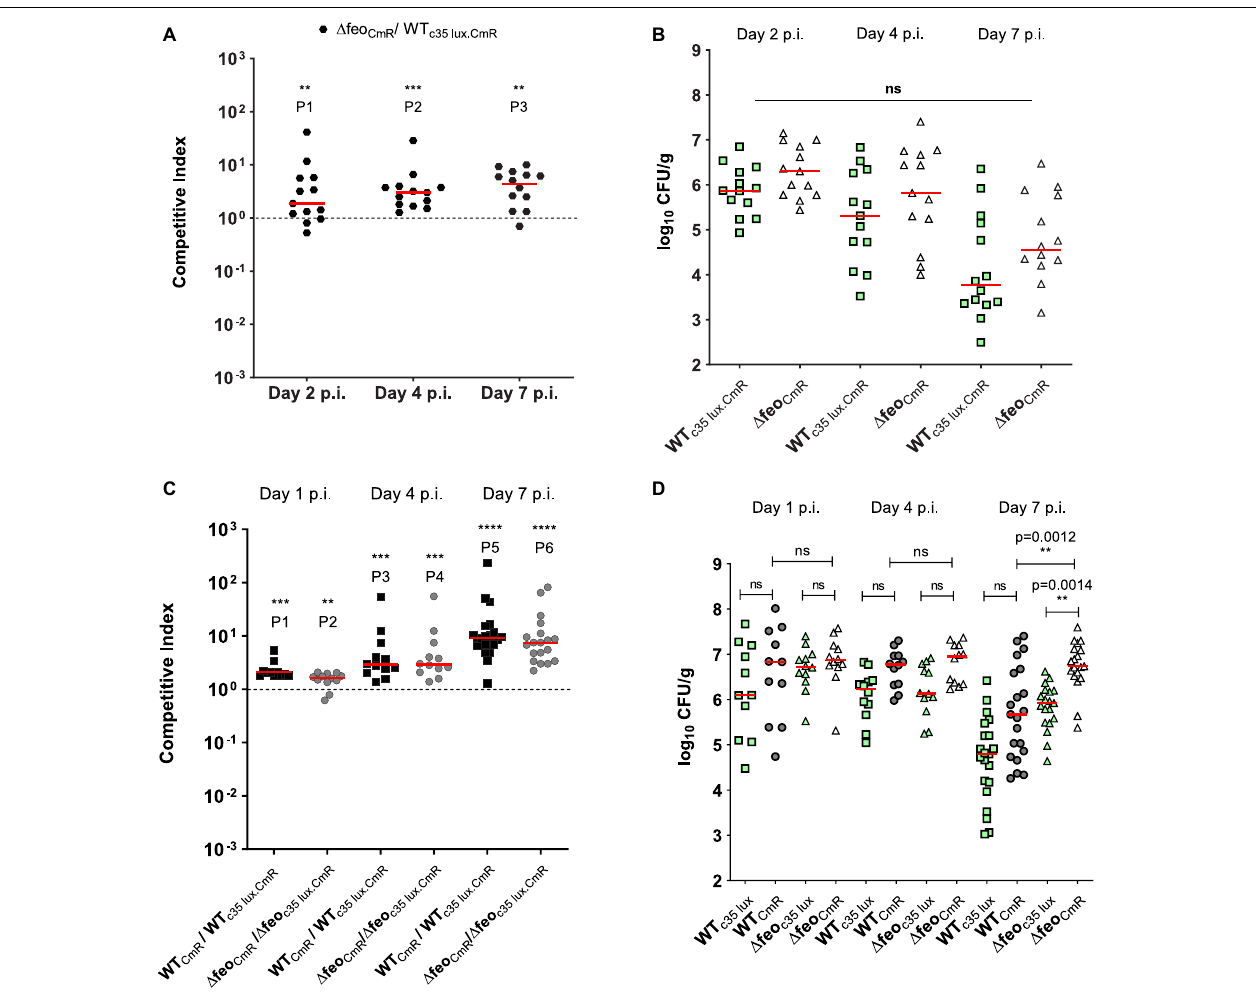
FIGURE 3 | (A) Competitive index scores; (cid:49) feoABC with chloramphenicol resistant marker ( (cid:49) feo CmR ) vs. bioluminescent wildtype SEn strain in cecal tissue. Thirteen broilers/group. Each symbol represents CI value obtained from a bird. ∗∗ P1 = 0.0081, ∗∗∗ P2 = 0.0002, ∗∗ P3 = 0.0012. (B,D) Bacterial load in the cecal content. Each symbol represents a colony count of a particular bird, for each strain. Mean differences were analyzed using appropriate statistic test. ns, not significant. (C) Competitive indexes for non-bioluminescent strain vs. bioluminescent strain. ∗∗∗ P1 = 0.001, ∗∗ P2 = 0.0034, ∗∗∗ P3, ∗∗∗ P4 = 0.0005, ∗∗∗∗ P5, ∗∗∗∗ P6 ≤